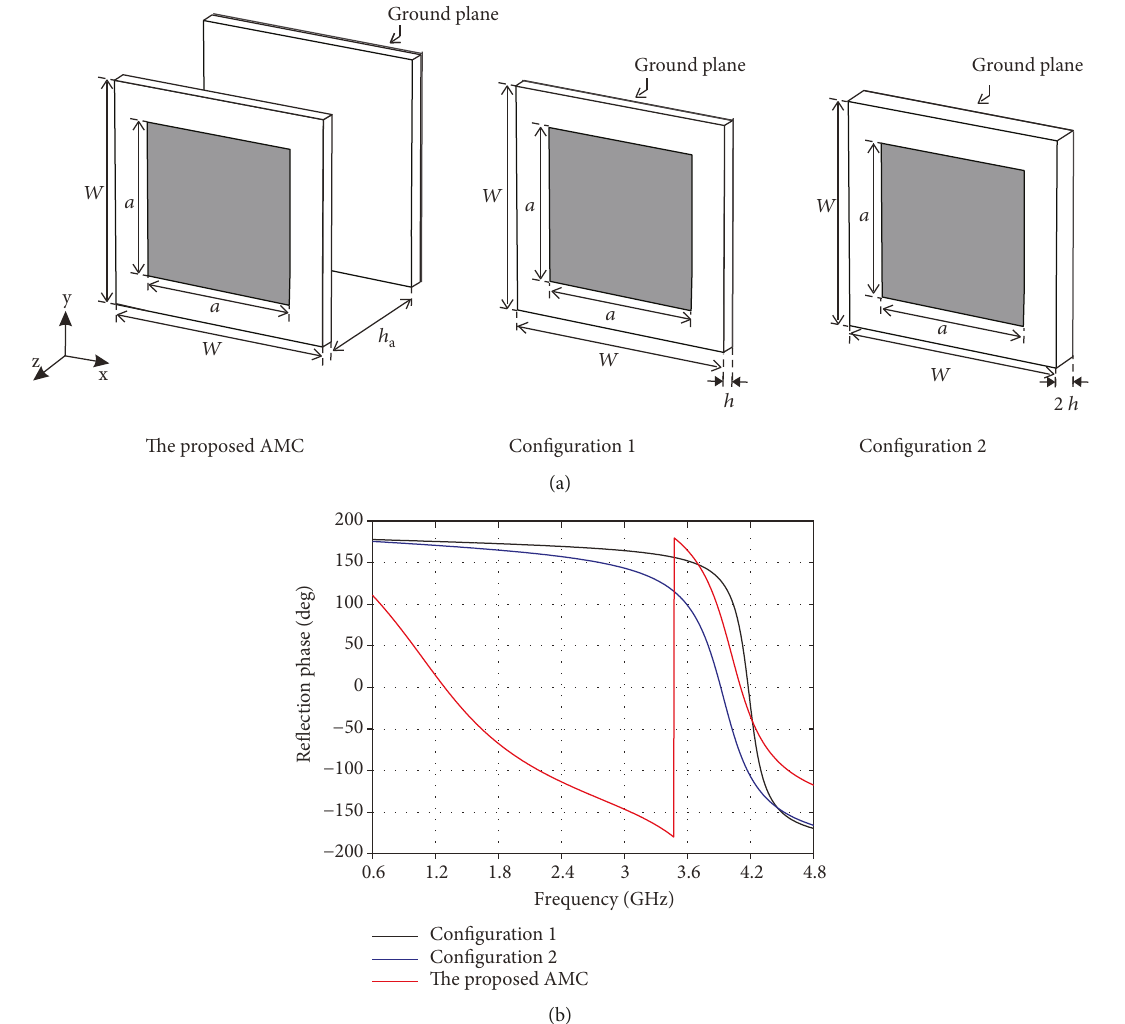
Figure 9: (a) Geometry of the unit cells of the AMC structures and (b) simulated re fl ection phases.